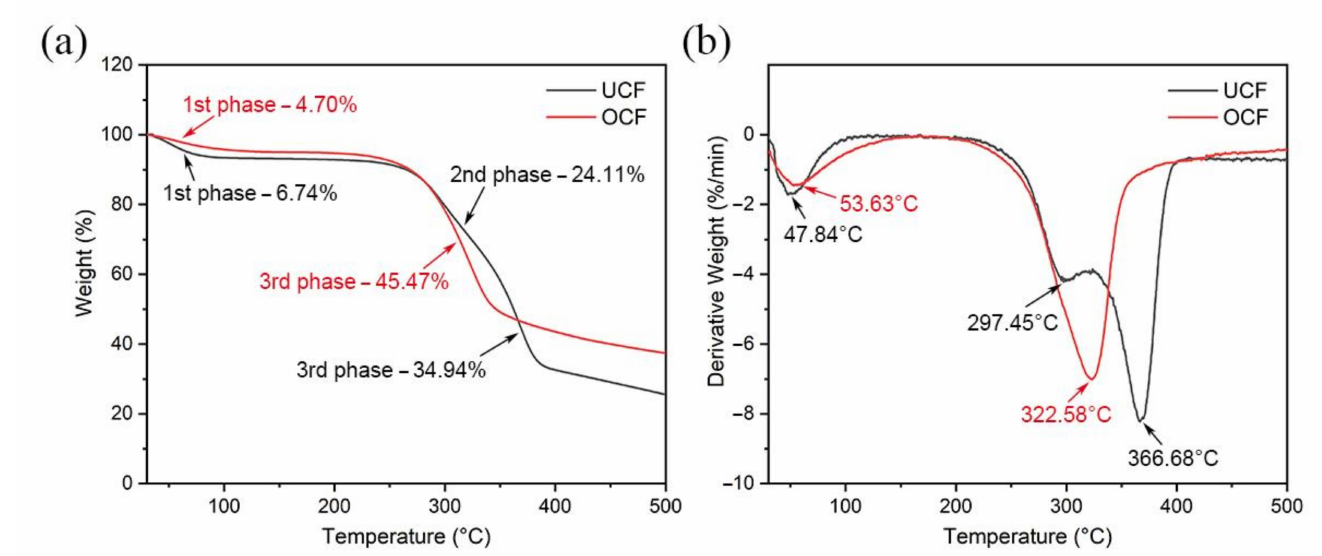
Figure 12. ( a ) The TGA curves of untreated (black) and treated (red) coir fibers under optimal conditions. ( b ) The DTG curves of untreated (black) and treated (red) coir fibers under optimal